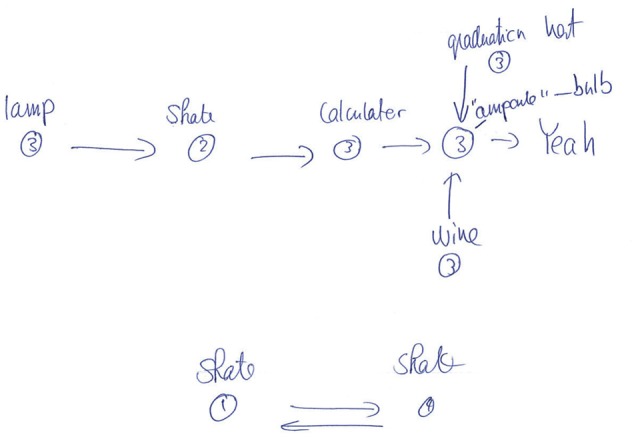
Example drawing for one observer for the structure experiment (non-embeddable condition). In this typical example, the observer remembers some paths to the goal, but not the full structure of the environment (compare with Figure 1B).